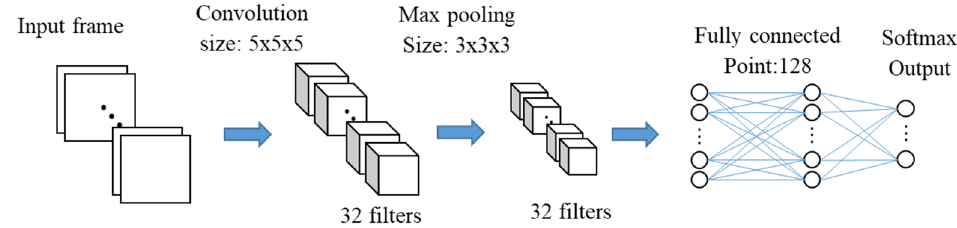
Figure 8. Flow chart of the 3D convolutional neural network (CNN).